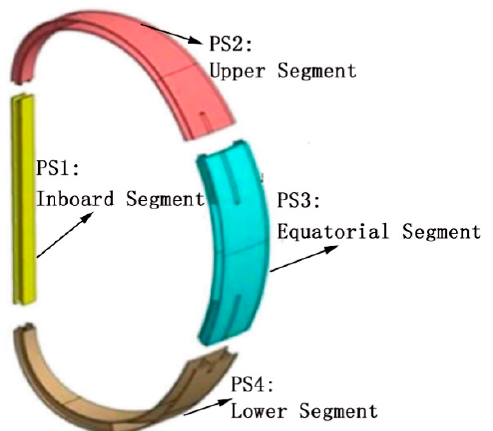
Figure 1. Assembly of the 1/32 vacuum vessel (VV) mock-up, including PS1 (inboard segment), PS2 (upper segment), PS3 (equatorial segment), and PS4 (lower segment).